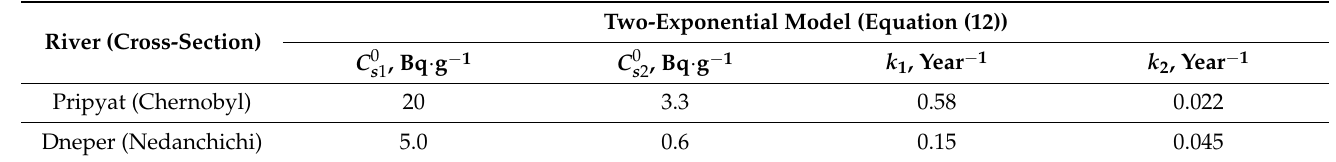
Table 3. Parameters used to approximate time dependence of particulate 137 Cs in Pripyat River at Chernobyl and Dneper River at Nedanchichi by two-exponential model (Equation (12)). Two-Exponential Model (Equation (12)) River (Cross-Section) Pripyat